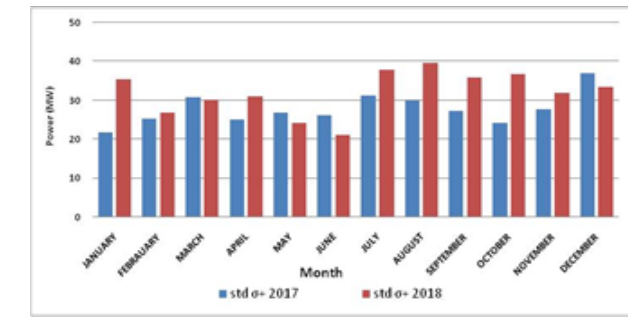
Figure 26. Comparison between average values of downward power ramps in 15 min interval for each month for years 2017 and 2018.